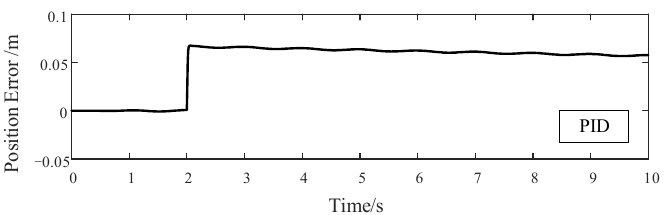
Figure 10. ADRRAC Tracking Error of 1 Hz Sinusoidal Signal.